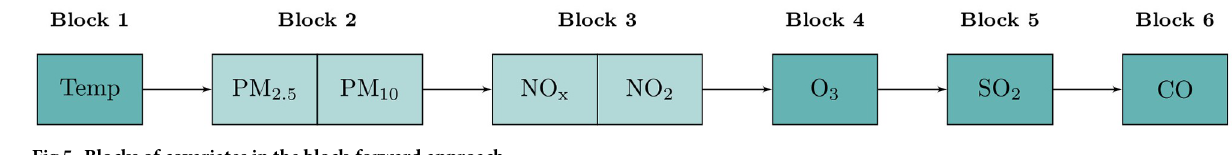
Fig 5. Blocks of covariates in the block-forward